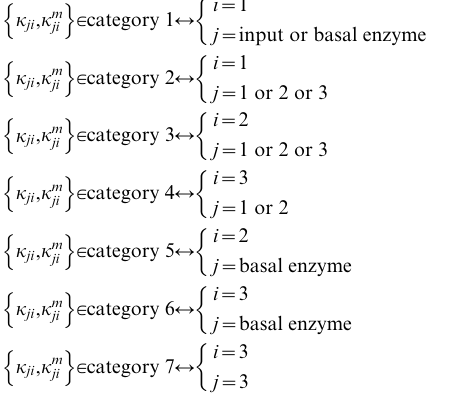
Figures 7. Illustrating the different parameter categories. The links of each topology (and thus their corresponding parameters) are divided into 7 categories: k ji , k m ji